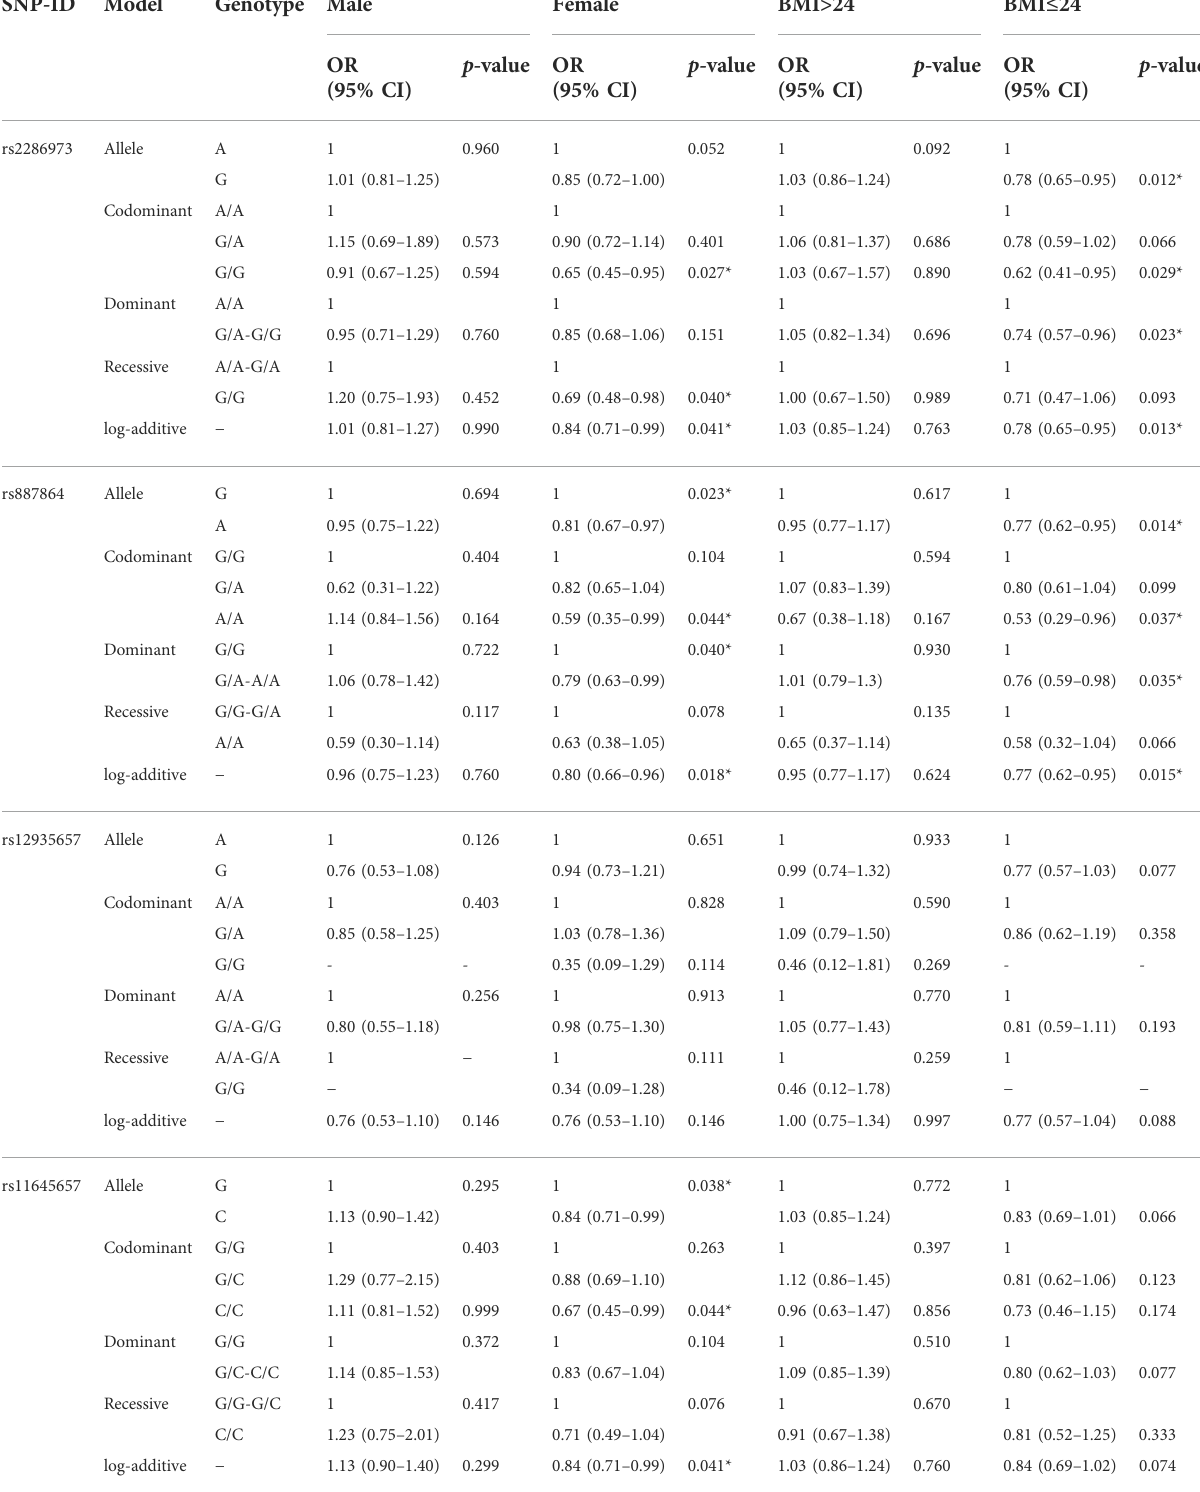
TABLE 5 Association between CLEC16A variants and AR risk strati fi ed by sex and